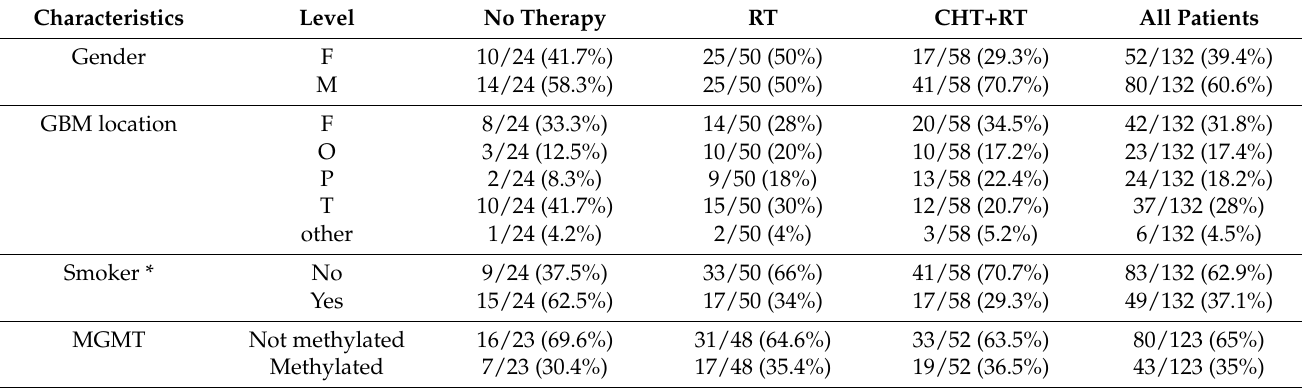
Table 2. Demographic data for the patient cohort and information on the prevalence of low and high copy numbers of the studied